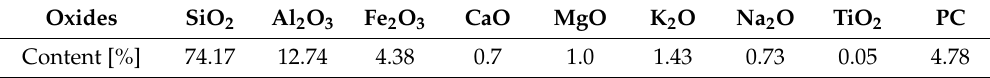
Figure 1. Granulometry of sandy clay [16]. Table 1. Oxide composition of clay, determined according to romanian standard STAS 9163.